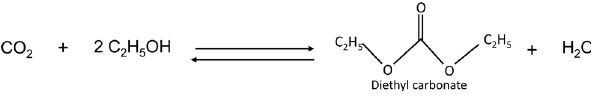
Figure 1: Ethanol carbonation with CO